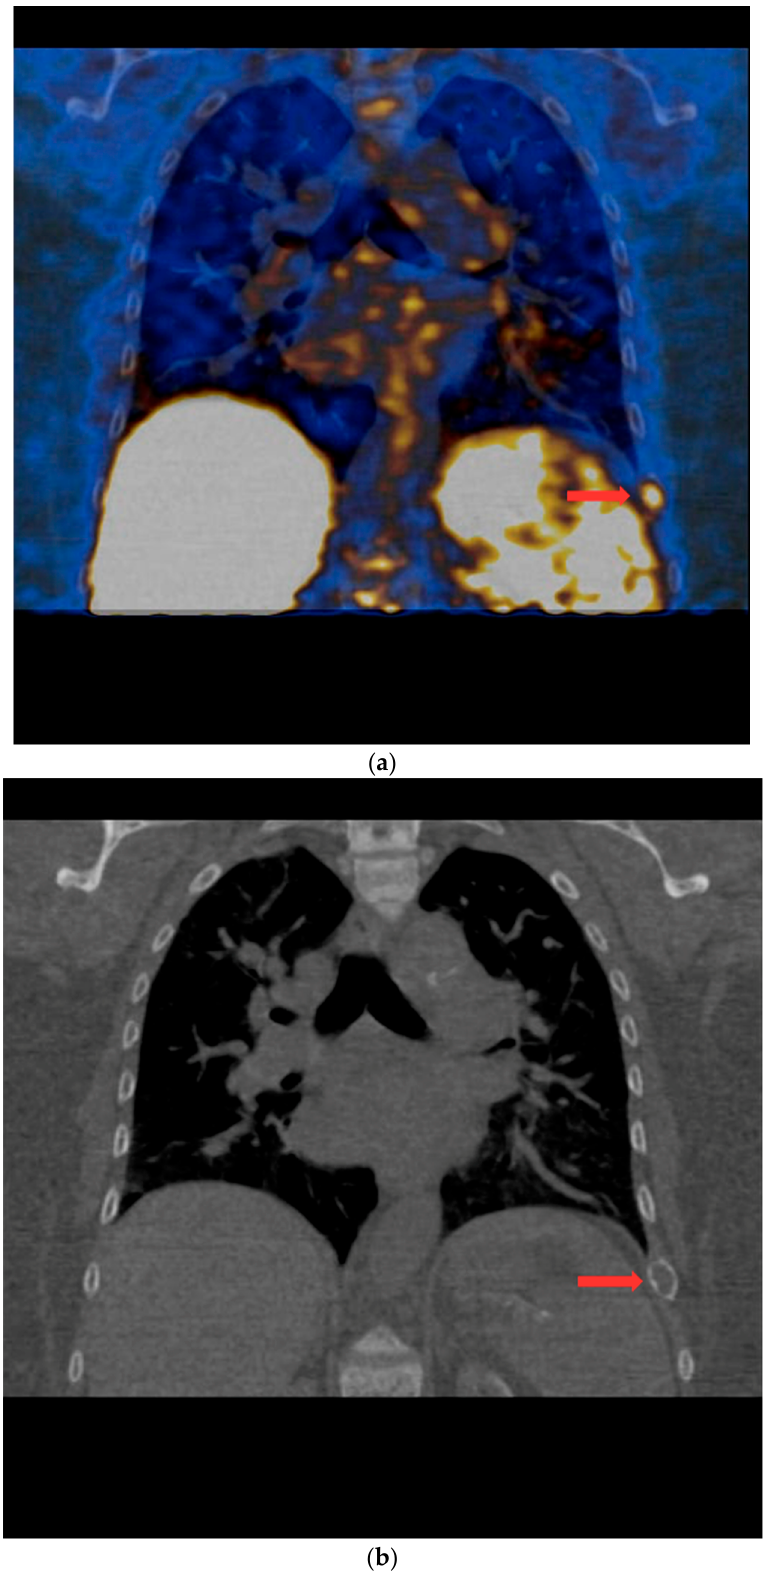
Figure 5. ( a ) PET/CT with [ 11 C] MET—frontal projection. Visible focal increased radiotracer uptake (red arrow) corresponding to the brown tumor in the middle part of the left 9th rib. ( b ) Low-dose CT scan performed during PET/CT with [ 11 C]MET in the same patient. In the location of the focus of increased accumulation of the radiotracer corresponding to the brown tumor of the left 9th rib, the distention of the contour of this rib is visible (red arrow).